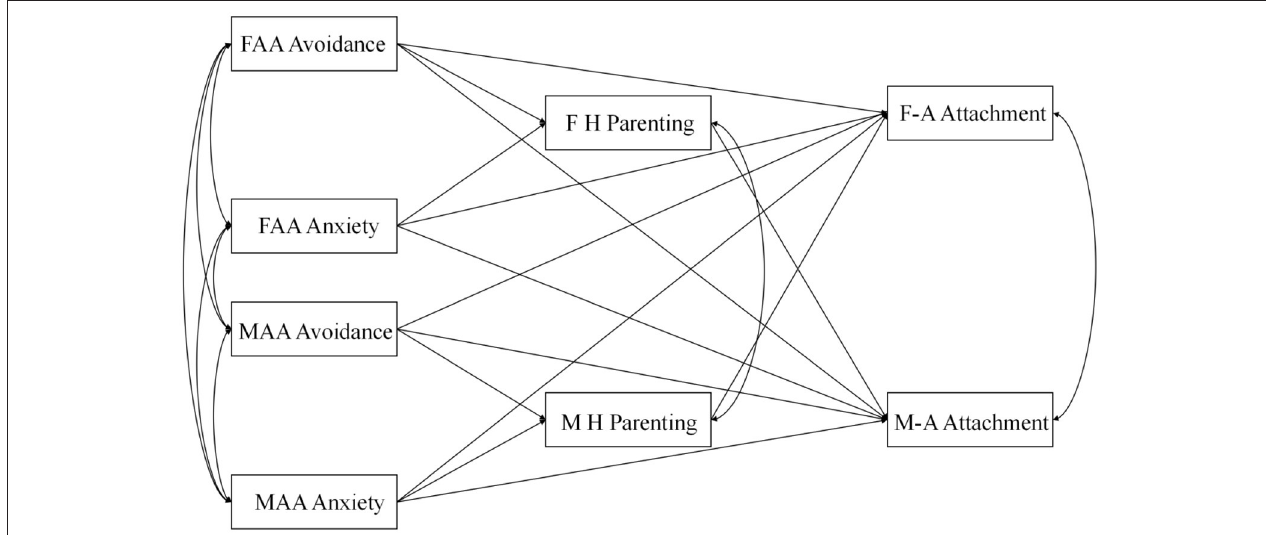
FIGURE 1 | Hypothesis model. FAA Avoidance, father adult attachment avoidance; FAA Anxiety, father adult attachment anxiety; MAA Avoidance, mother adult attachment avoidance; MAA Anxiety, mother adult attachment anxiety; F H parenting, father harsh parenting; M H parenting, mother harsh parenting; F-A Attachment, father-adolescent attachment; M-A Attachment, mother-adolescent